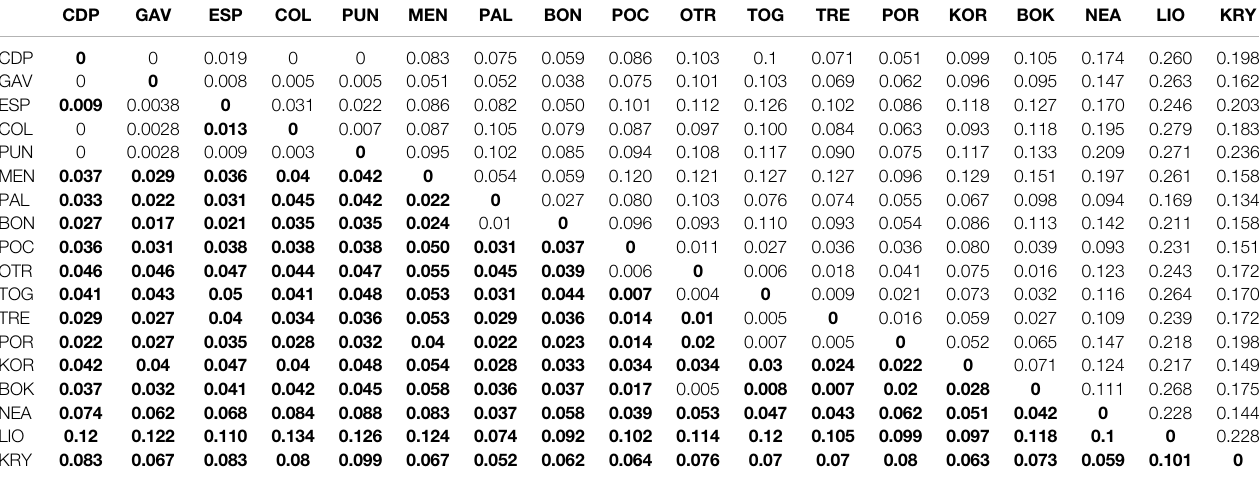
TABLE 4 | Pairwise F ST values for the analysed populations of C. caespitosa (lower diagonal).